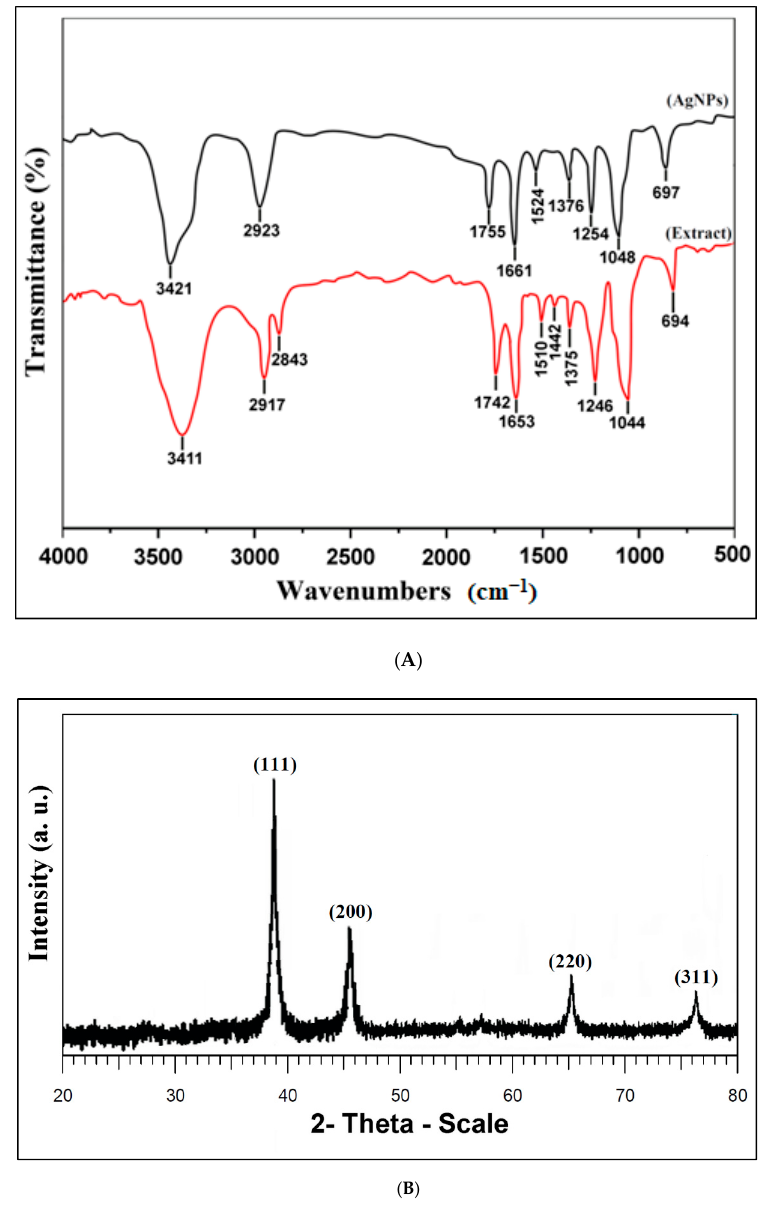
Figure 2. ( A ) The Fourier-transform infrared (FTIR) spectrum of the O. persica leaf extract ( ) ) and and the phytofabricated AgNPs (separated from the reaction mixture and cleaned with water) ( ); ( B ) The X -ray diffraction (XRD) pattern of the AgNPs phytofabricated by using the O. persica ); ( B ) leaf extract.